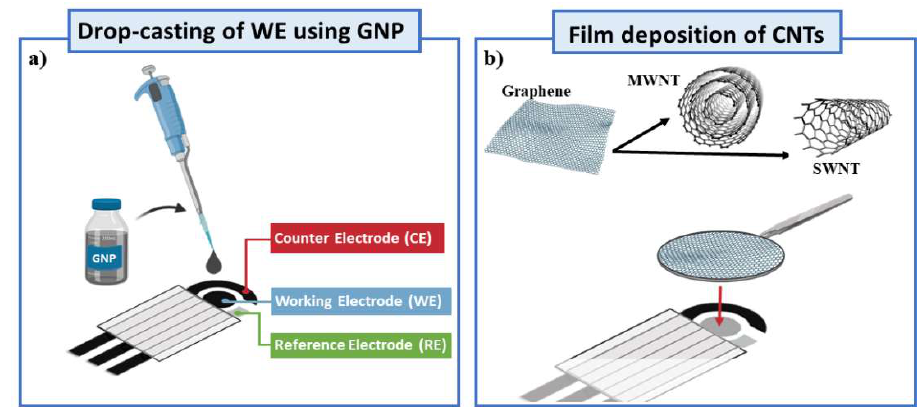
Figure 2. Schematic representation of nano-engineered-SPE. ( a ) Classical drop-casting of WE surface using a dispersion of GNPs, ( b ) innovative deposition of CNT-based films.